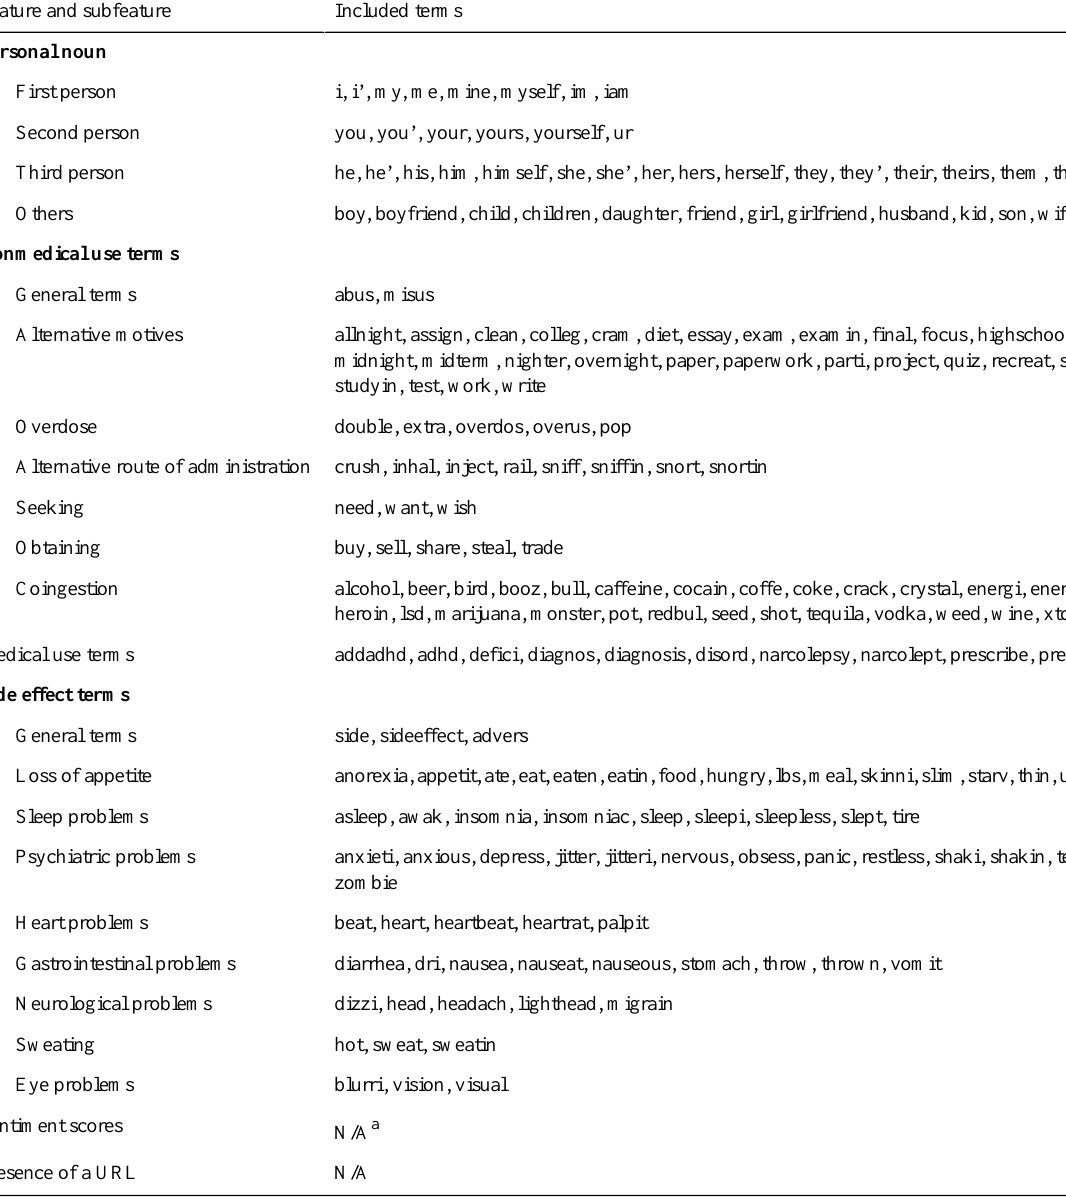
Included termsFeature and